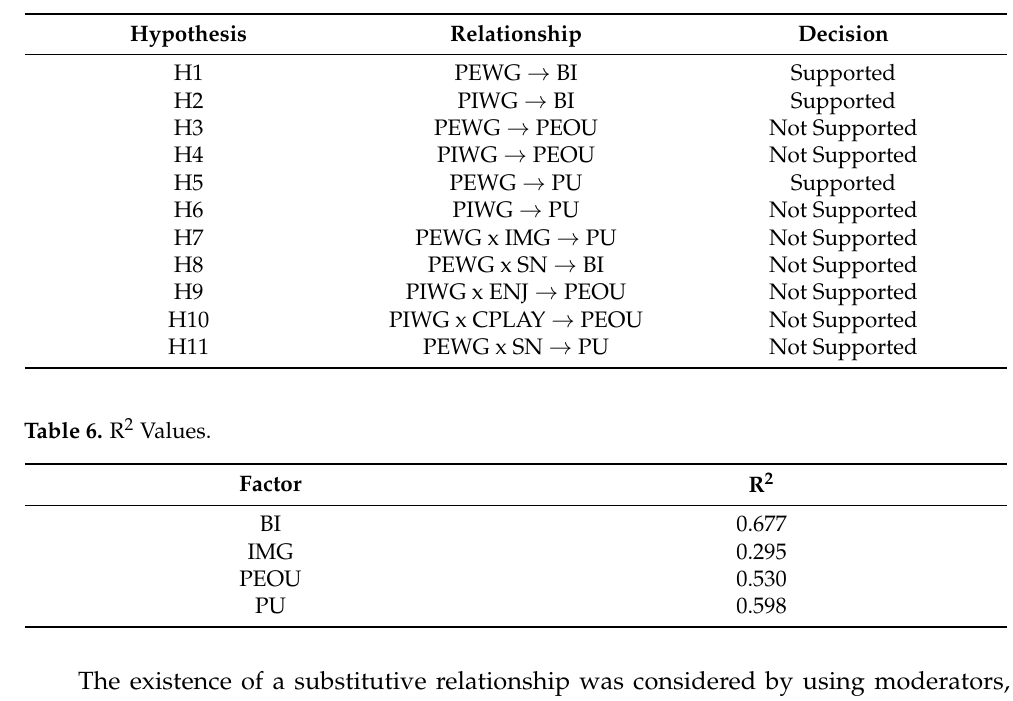
Table 5. Hypothesis Testing Results.